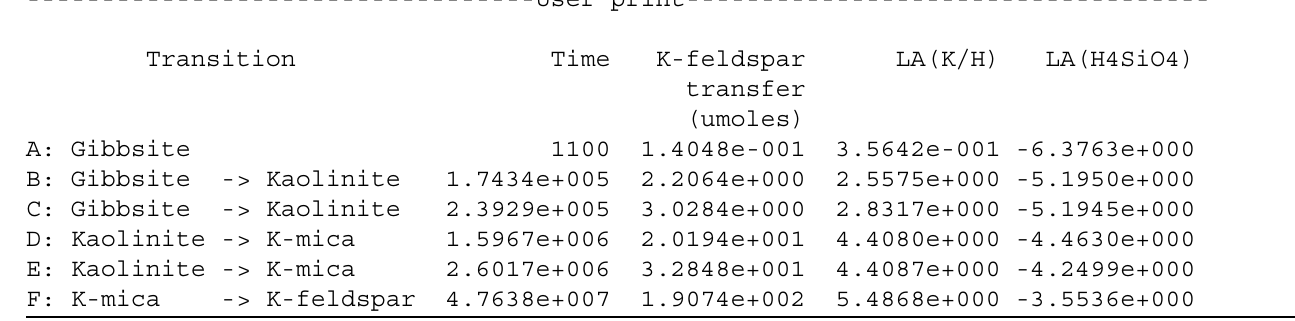
Table 24. Phase transitions identified by the RATES Basic program and printed to the output file by